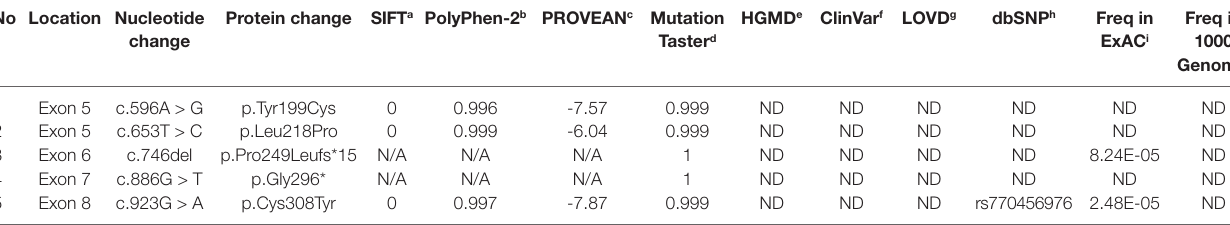
TABLE 2 | In silico prediction and analysis of the previously unreported ACADSB gene variants. No Location Nucleotide